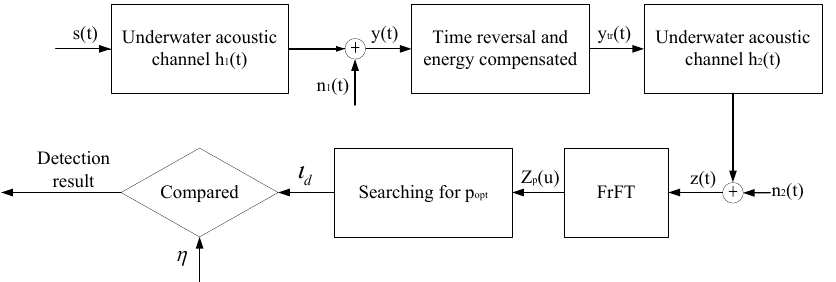
Figure 2. Schematic illustration of the novel method based on TR-FrFT used to detect LFM signal in an underwater multi-path